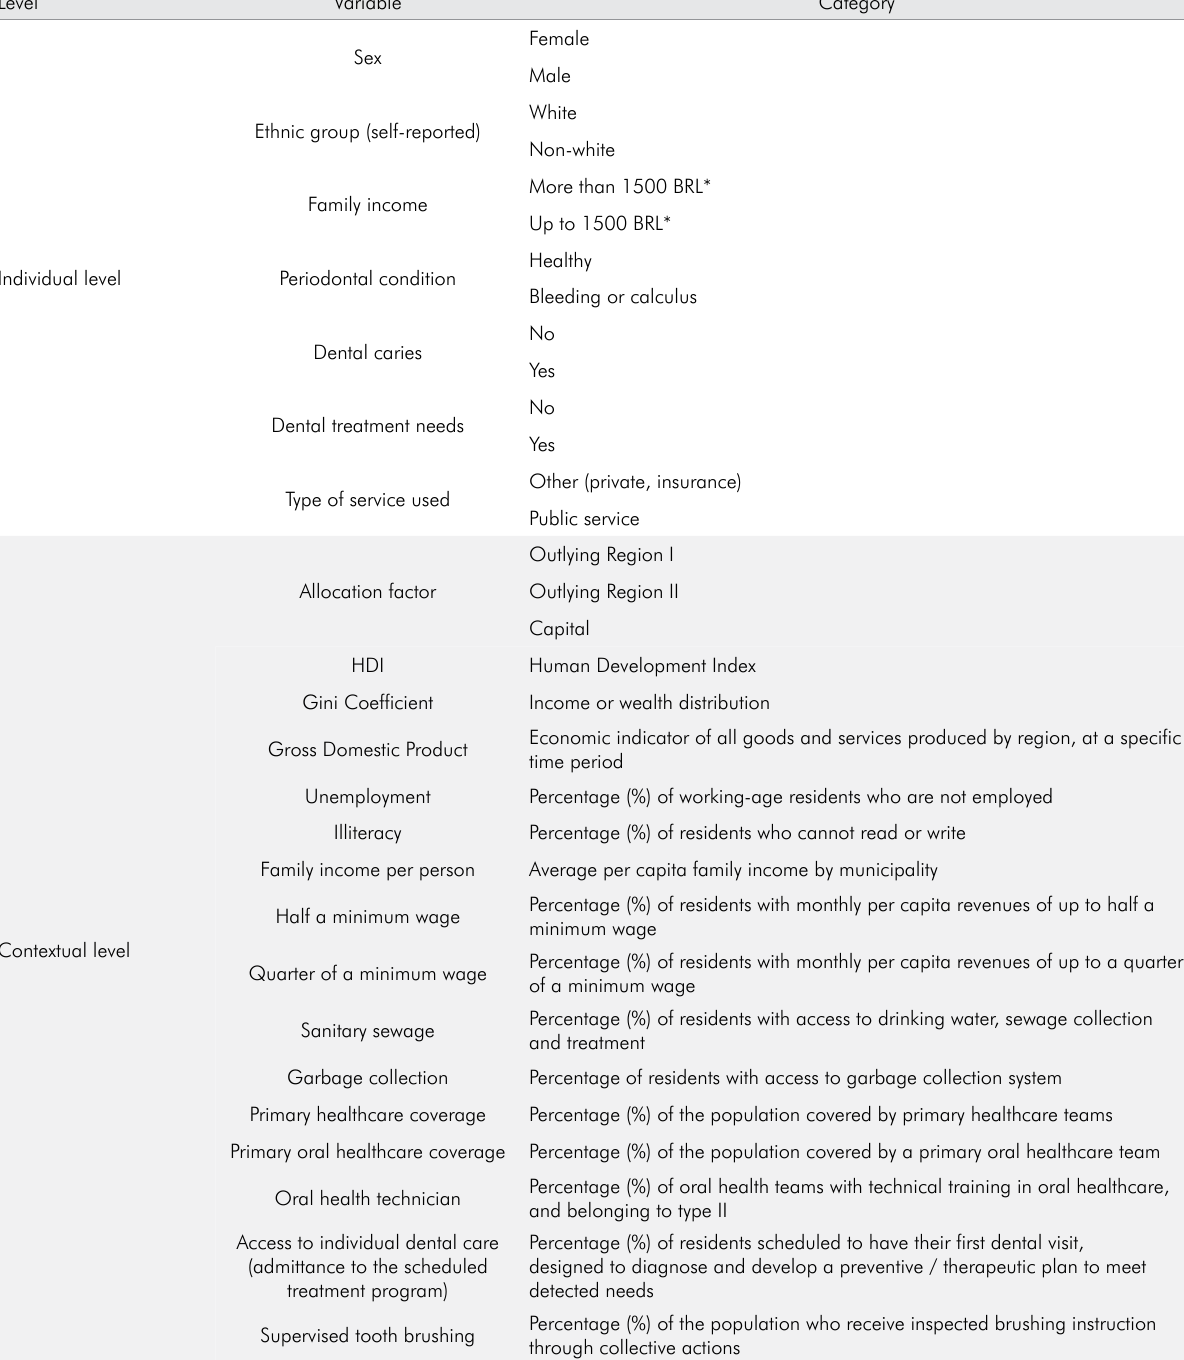
Table 1. Description of variables according to the levels analyzed - SB Minas Gerais Survey, Brazil, 2012